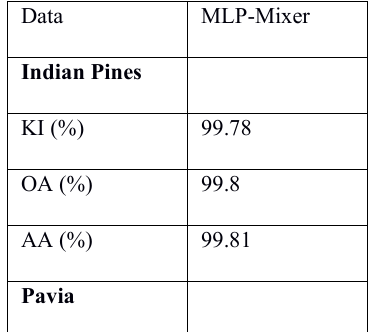
Table 1 . Classification results of HIS data by the MLP-Mixer (KI= Kappa Index, OA= Overall Accuracy, AA= Average